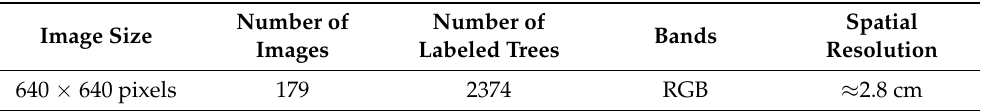
Table 1. Details of the labeled